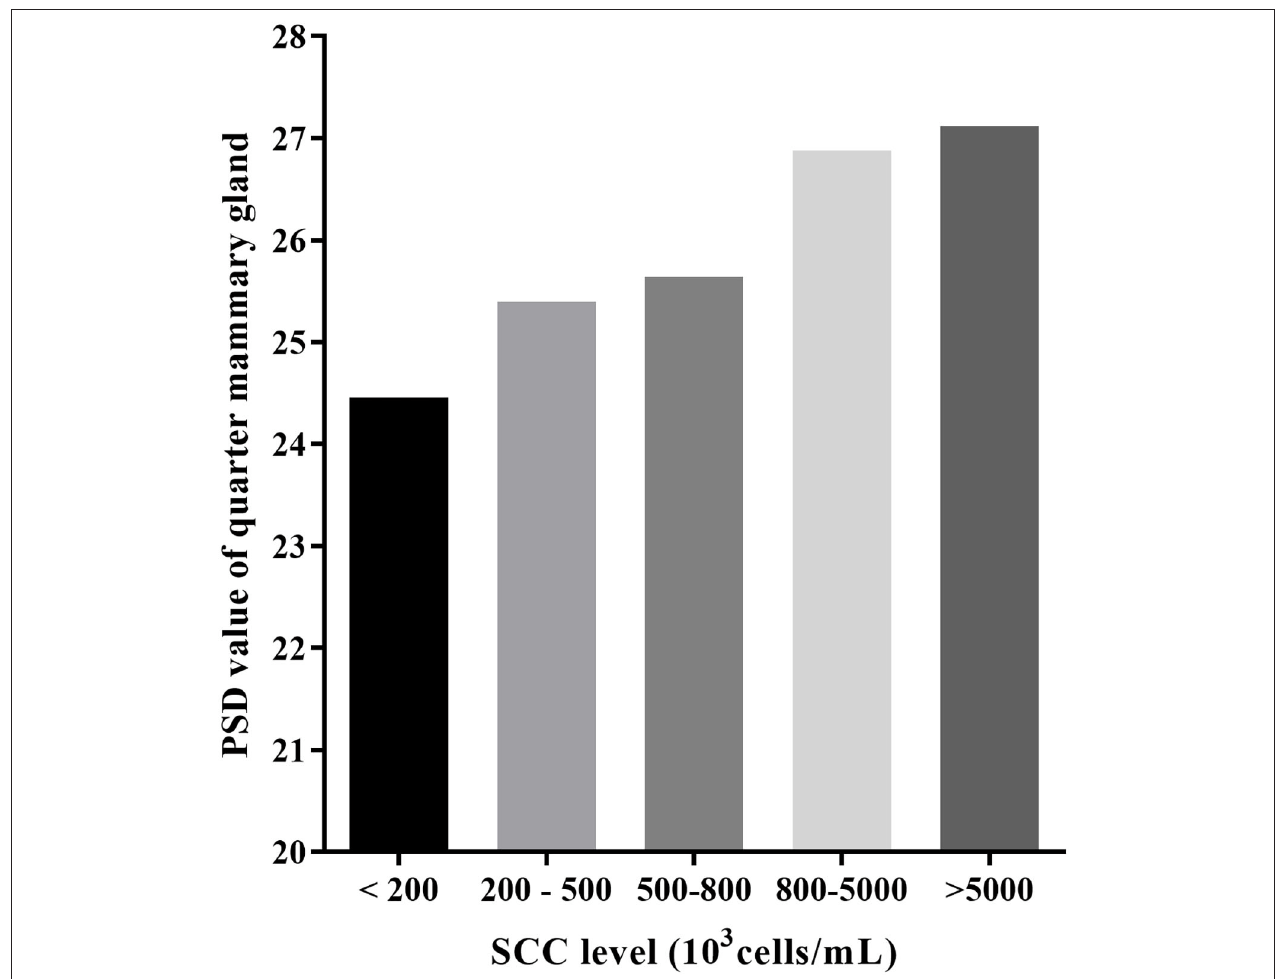
FIGURE 2 | The least square means of PSD by SCC categories for